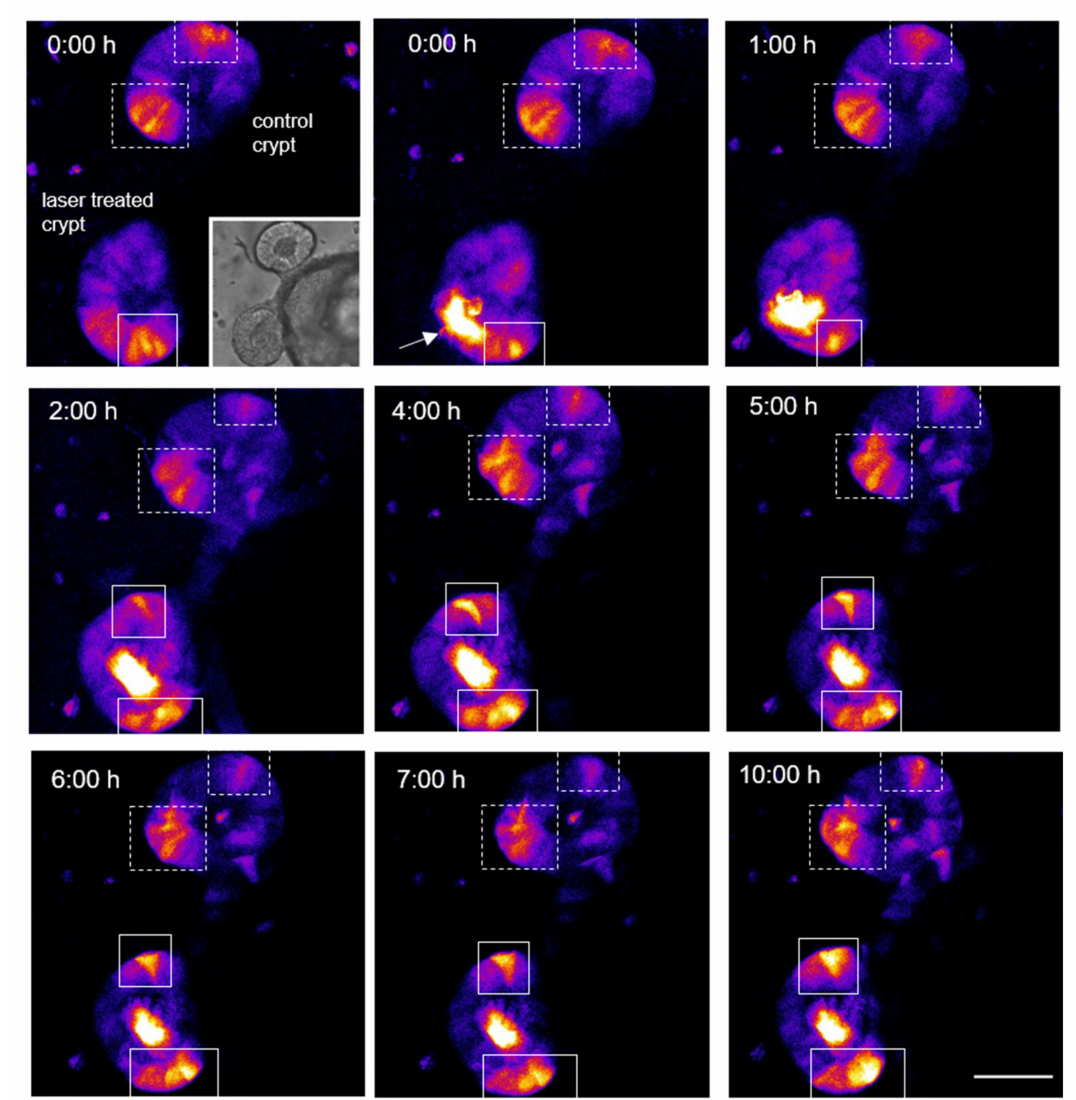
Figure 8. Time course of a regeneration process after ablation of a cell within the crypt area leads to an increased Wnt pathway signal around the ablation site. The fluorescence signal of a z-projection (confocal microscopy, 52 µ m, z-step size 2 µ m) of two crypts of the same colonoid (top row left, small icon) is shown. The fluorescence signal is triggered by a promotor, which controls the expression of an EGFP and is sensitive for transcription factors of the Tcf/Lef -family [26]. A cell was ablated in the lower crypt zone (indicated by the arrow, strong autofluorescence); the upper crypt serves as a control. Increasing fluorescence in the neighboring cells (white boxes) in the treated colonoid, as depicted in this representative time series, was observed in 7 out of 14 ablated crypts. The upper control crypt showed a fluorescence signal at a constant level (in the white, dashed boxes) over time. Scale bar 50 µ m. Supplementary Video S7 shows the time course with additional